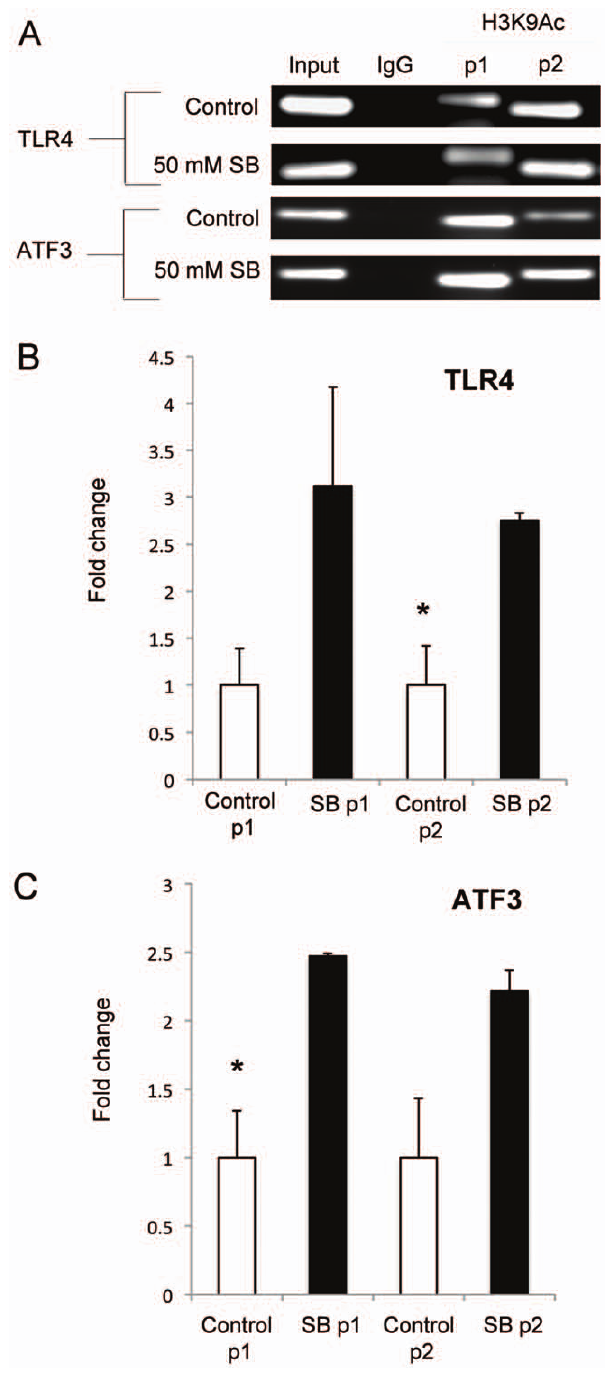
Figure 8. ChIP-qPCR at the TLR4 and ATF3 loci. (A) Representative results of qPCR experiments amplifying two separate regions of the TLR4 and ATF3 gene promoters (separate p1 and p2 primer sets for each gene) after enrichment of H3K9Ac-DNA complexes from cells obtained after SB treatment or controls. Input= purified DNA before selection; IgG= control for non-specific antibody binding to DNA. Quantitative PCR was used to determine that the TLR4 locus (B) and the ATF3 locus (C) were enriched for H3K9Ac at two separate promoter locations after 48 hours of SB treatment. Bars represent the mean fold change + s.d. (n=3). Asterisk (*) indicates that SB treatment group is significantly different (p , 0.05) from the control treated group as determined by an unpaired Student’s t-test.